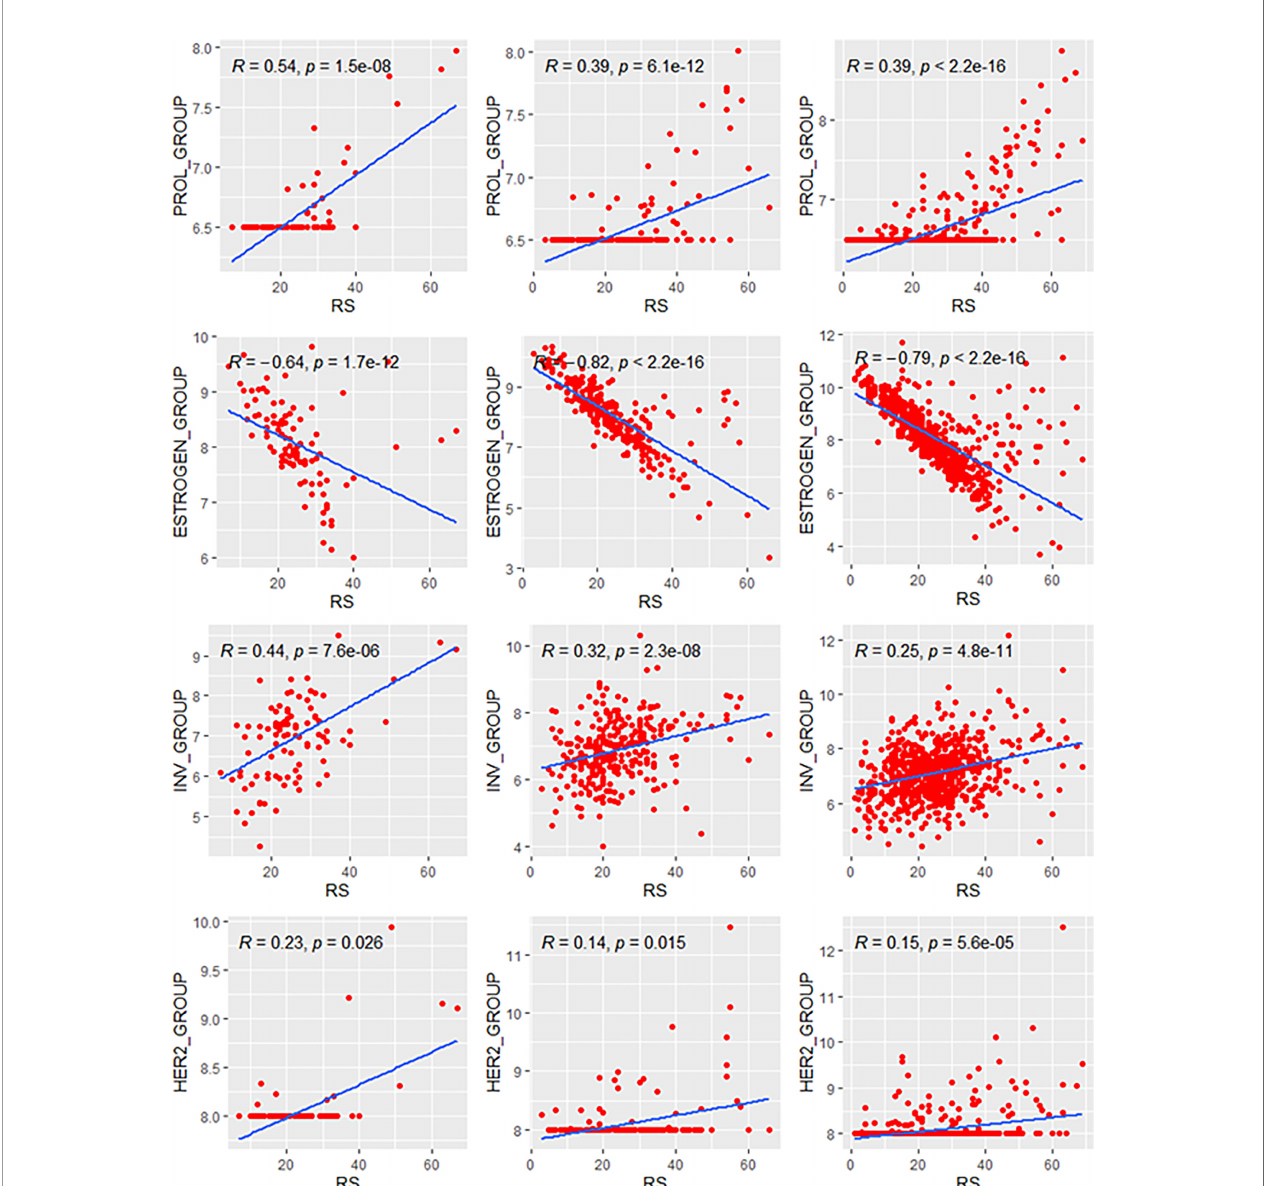
FIGURE 1 | Relationships of the RS with its proliferation module and estrogen module. Groups A, B, C were presented from left to right. RS, recurrence